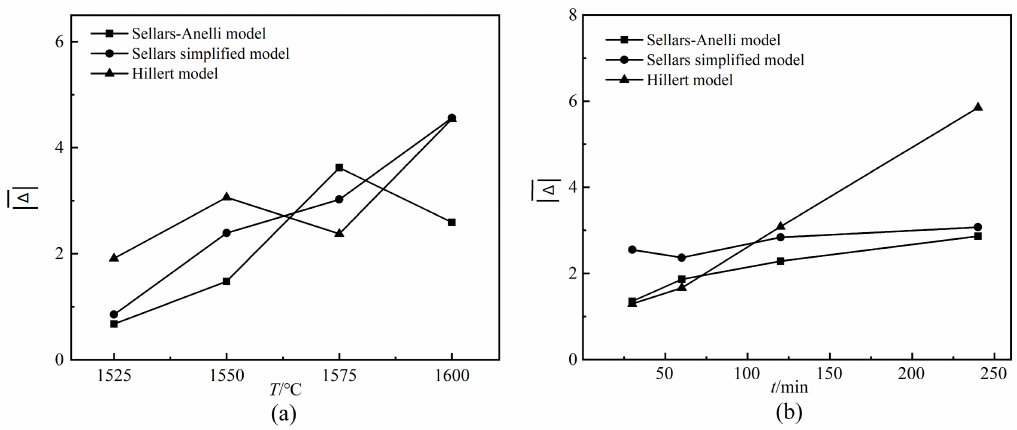
Figure 8. Relationship curves between | ∆ | and T , t : ( a ) Sintering temperature T ; ( b ) holding time